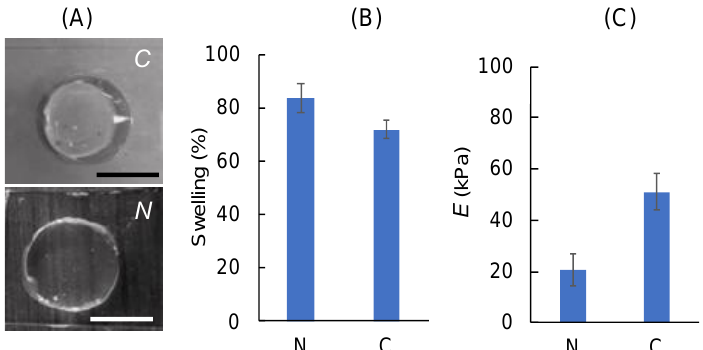
Figure 5. Mechanical characterization of the composite ( C ) and neat ( N ) hydrogels. ( A ) Pictures showing the hydrogels after swelling. Scale bars are 1 mm. ( B ) Percent swelling and ( C ) elastic modulus ( E ) of the hydrogels. Data are presented as mean ± std. deviation for n = 3 samples.